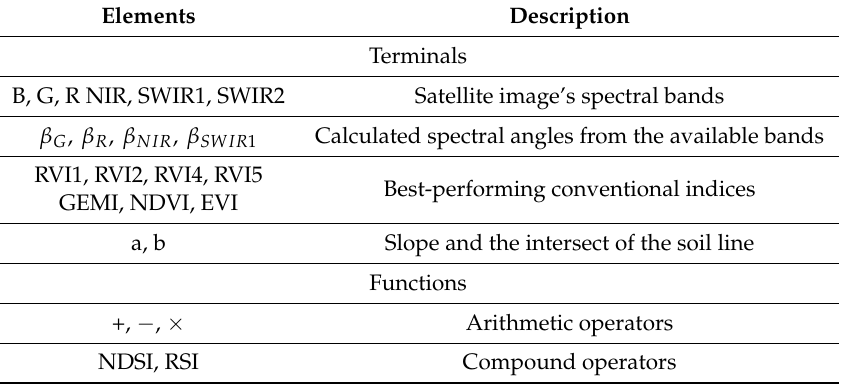
Table 3. Primitives’ set elements for the Experiments Section. NDSI, Normalized Difference Spectral Index; RSI, Ratio Spectral